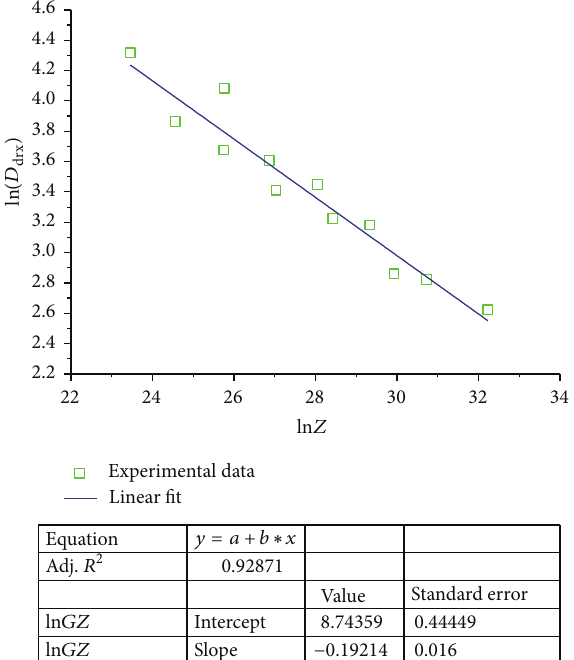
Figure 17: Relationship between ln (𝐷